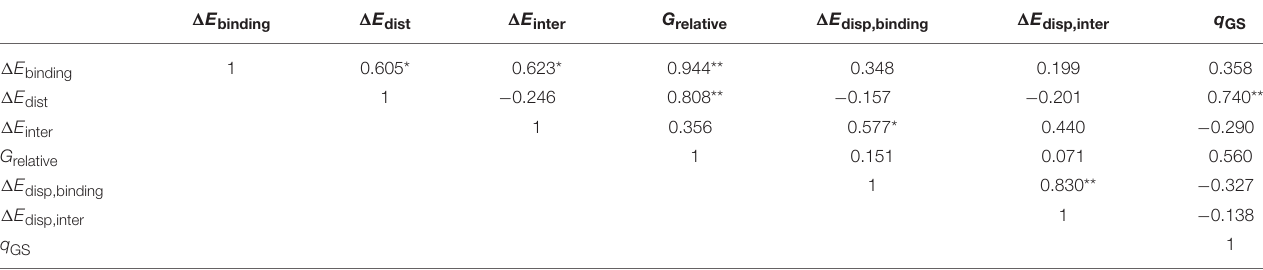
TABLE 6 | Pearson correlation analysis between energies and CT a .